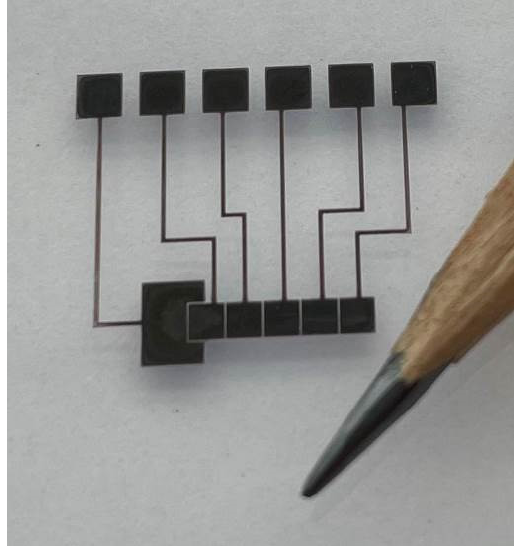
Figure 2. Photograph of Ag-ink-printed DMF circuit on a PET substrate.